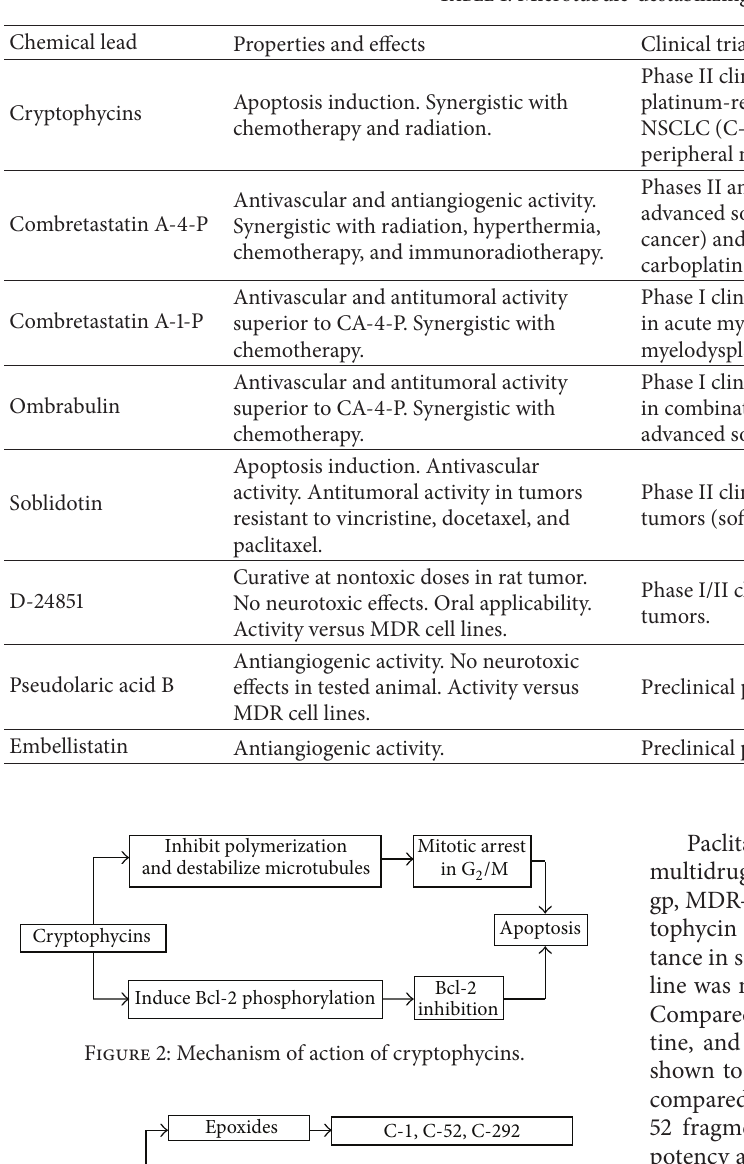
Table 1: Microtubule-destabilizing agents.